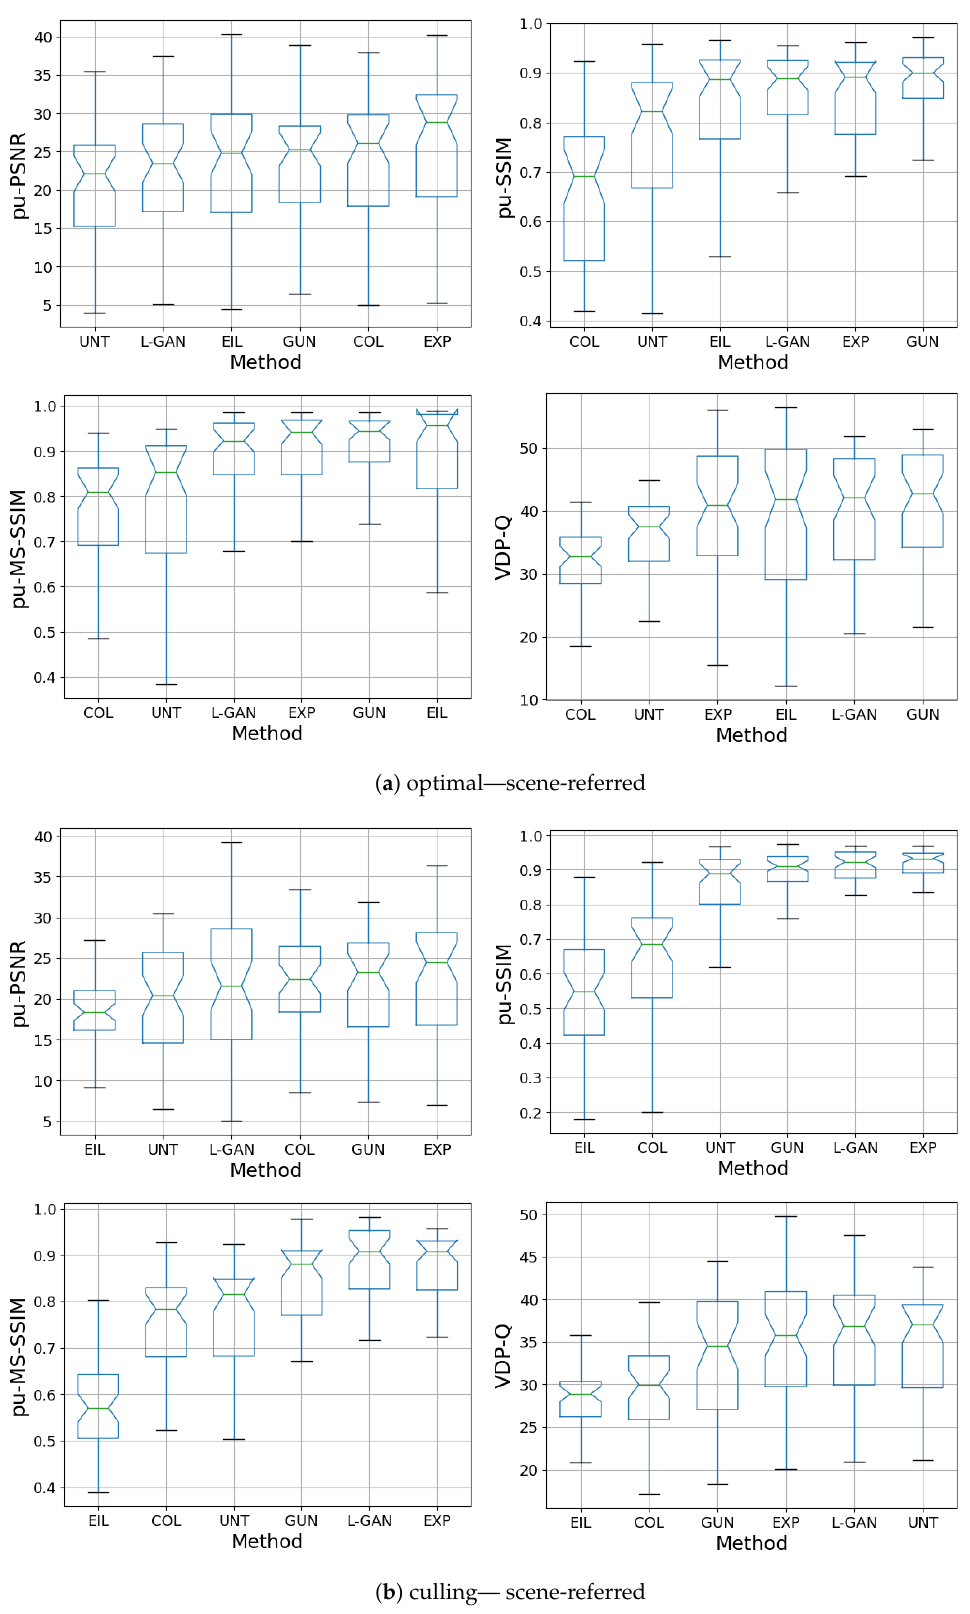
Figure 7. Box plots of all metrics for scene-referred HDR obtained from LDR culling and optimal exposures. The DHH method is referred to as L-GAN in the